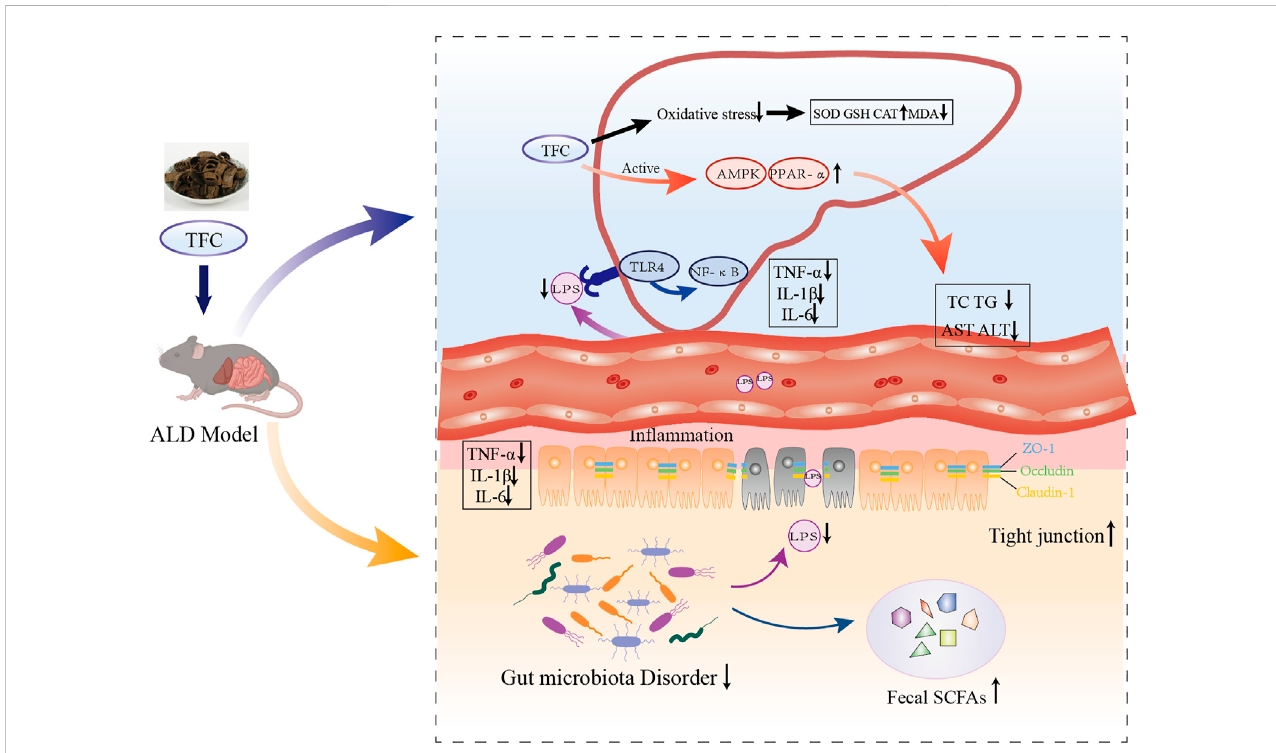
FIGURE 10 Schematic illustration on mechanism of action of TFC against alcoholic liver disease based on “ gut-liver axis ” . TFC reduces oxidative stress caused by ALD, activates the AMPK/PPARa pathway to reduce lipid accumulation, regulates intestinal fl ora disorders caused by ALD, restores SCFAs in the cecum, and reduces in fl ammatory responses in the liver and intestine via “ gut-liver axis ”